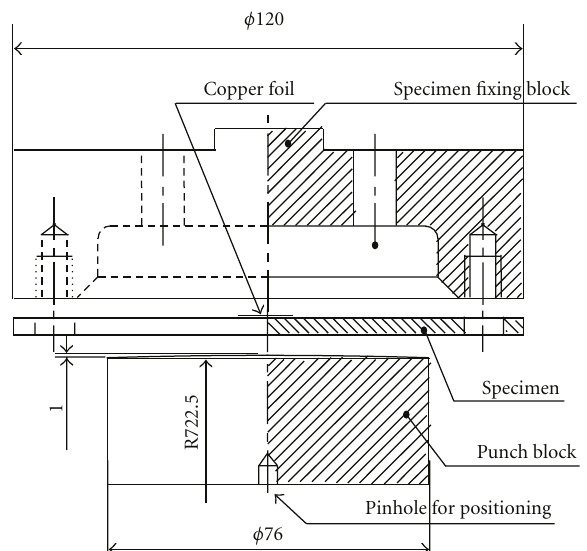
Figure 7: Disk-bending apparatus.